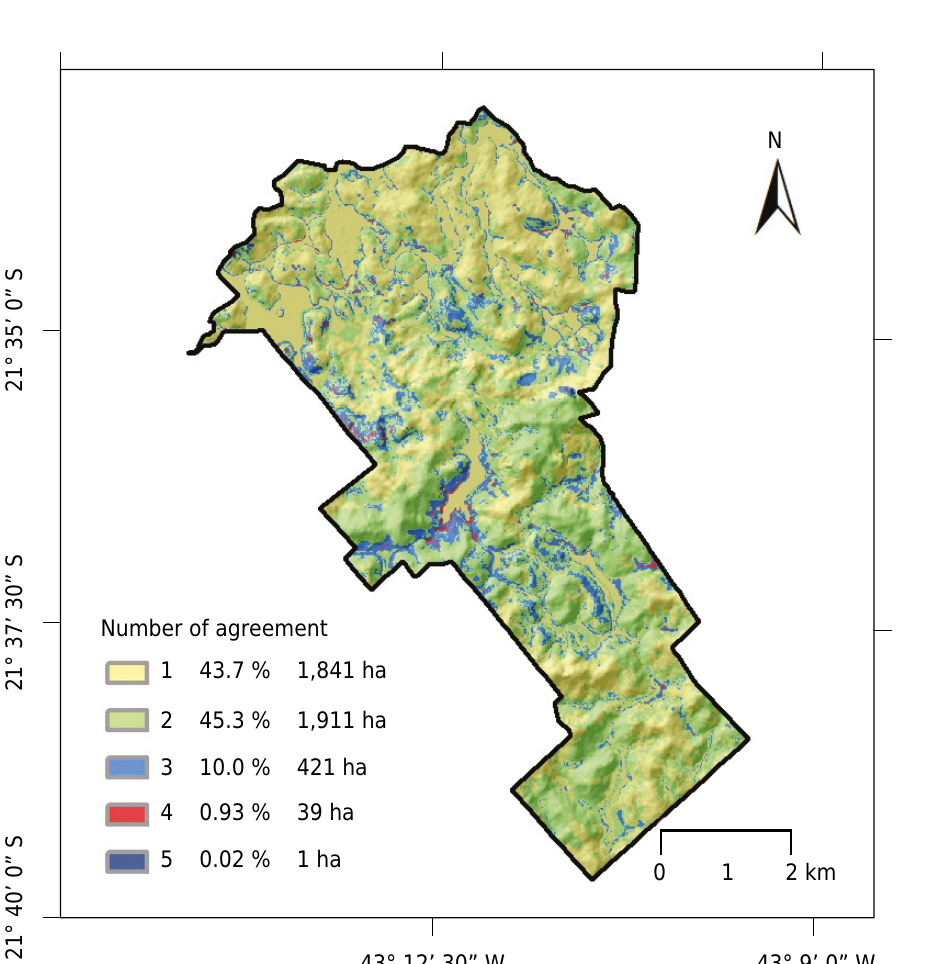
Figure 5. Map of MU variability among the eight soil maps generated with the machine learning algorithms in the Dênis Gonçalves Settlement (the values 1, 2, 3, 4, and 5 represent the number of distinct MUs assigned by the algorithms in a given pixel of the soil map, where 1 means agreement of all